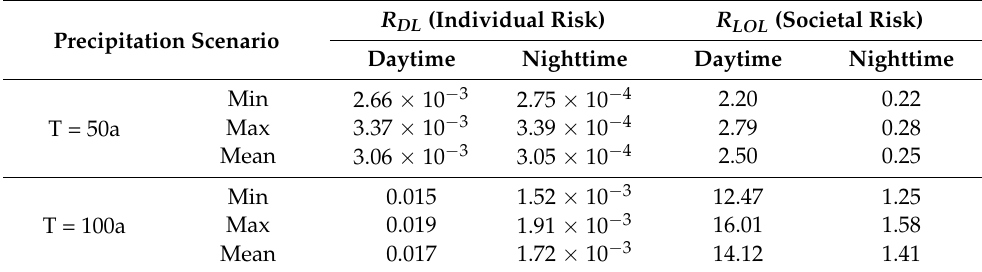
Table 7. Societal and individual risks during daytime and nighttime under two precipitation